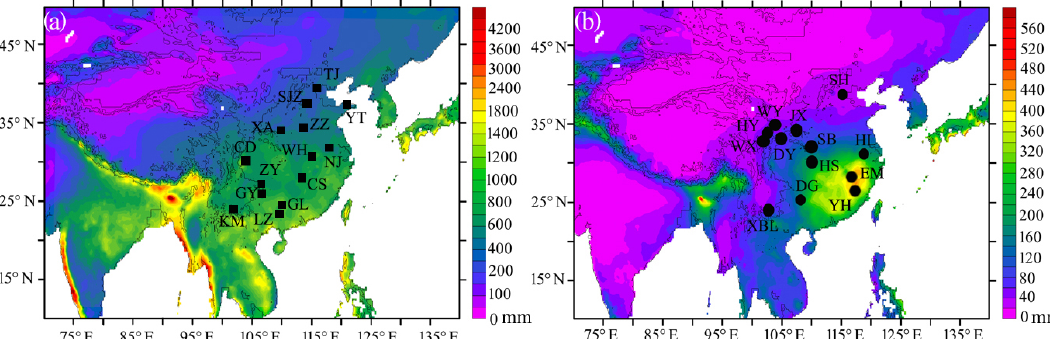
Figure 1. Overview map showing the spatial distribution of seasonal precipitation amount in China and locations mentioned in this study. (a) Regional mean EASM (May–September) precipitation amount (mm) in China from 1951 to 2007. The black squares represent the locations of the Global Network for Isotopes in Precipitation (GNIP) stations (TJ is Tianjin, YT is Yantai, SJZ is Shijiazhuang, XA is Xi’an, ZZ is Zhengzhou, NJ is Nanjing, WH is Wuhan, CS is Changsha, CD is Chengdu, ZY is Zunyi, GY is Guiyang, GL is Guilin, LZ is Liuzhou, KM is Kunming; details can be found in Table 1). (b) Regional mean SPR (March–April) precipitation amount (mm) in China from 1951 to 2007. The SPR is obvious in southeastern China from about 24 to 30 ◦ N and from 110 to 120 ◦ E. The black circles represent the locations of caves with published stalagmite records (SH is Shihua cave, Li et al., 2017; HL is Hulu cave, Wang et al., 2001; SB is Sanbao cave, Cheng et al., 2016; HS is Heshang cave, Hu et al., 2008; DG is Dongge cave, Yuan et al., 2004; XBL is Xiaobailong cave, Tan et al., 2017; WY is Wuya cave, Tan et al., 2014; DY is Dayu cave, Tan et al., 2009; WX is Wanxiang cave, Zhang et al., 2008; HY is Huangye cave, Tan et al., 2010; EM is E’mei cave, Zhang et al., 2018; and YH is Yuhua cave, Jiang et al., 2012). Precipitation data source: APHRODITE (Asian Precipitation – Highly-Resolved Observational Data Integration Towards Evaluation of Water Resources, APHRO_MA_V1101R2 product, (21)) (Yatagai et al.,